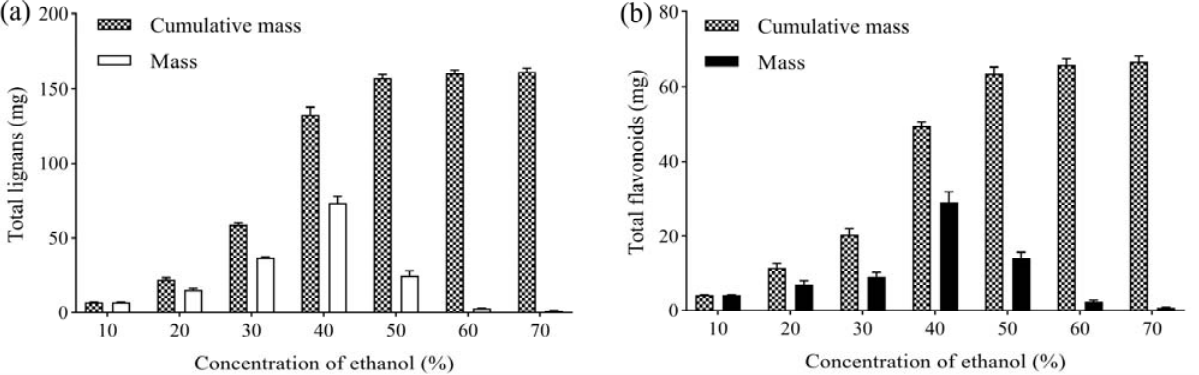
Figure 3. ( a ) Effect of ethanol concentration on mass of total lignans from V. amurensis extract; ( b ) effect of ethanol concentration on mass of total flavonoids from V. amurensis extract.